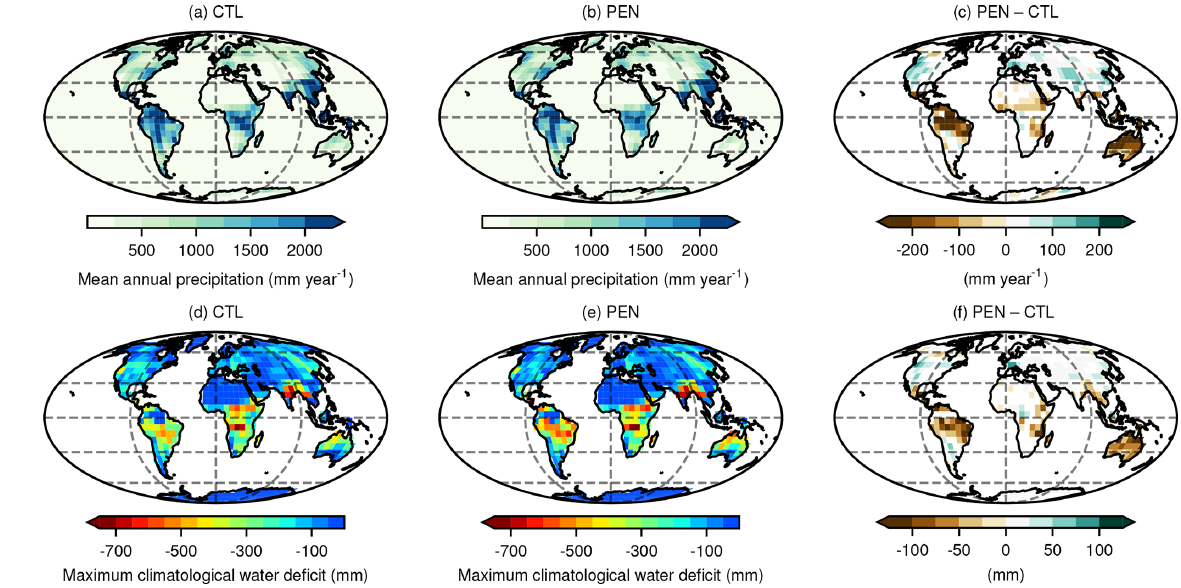
Figure 8. Annual mean results for the PEN simulation compared with the CTL simulation for MAP in CTL (a) and PEN (b) and their absolute difference (c) , and MCWD in CTL (d) and PEN (e) and their absolute difference (f) . In the difference panels, white depicts grid points with statistically non-significant difference ( α = 0 . 05). Grid lines are spaced every 30 ◦ from the Equator and 90 ◦ from Greenwich, in latitude and longitude, respectively.